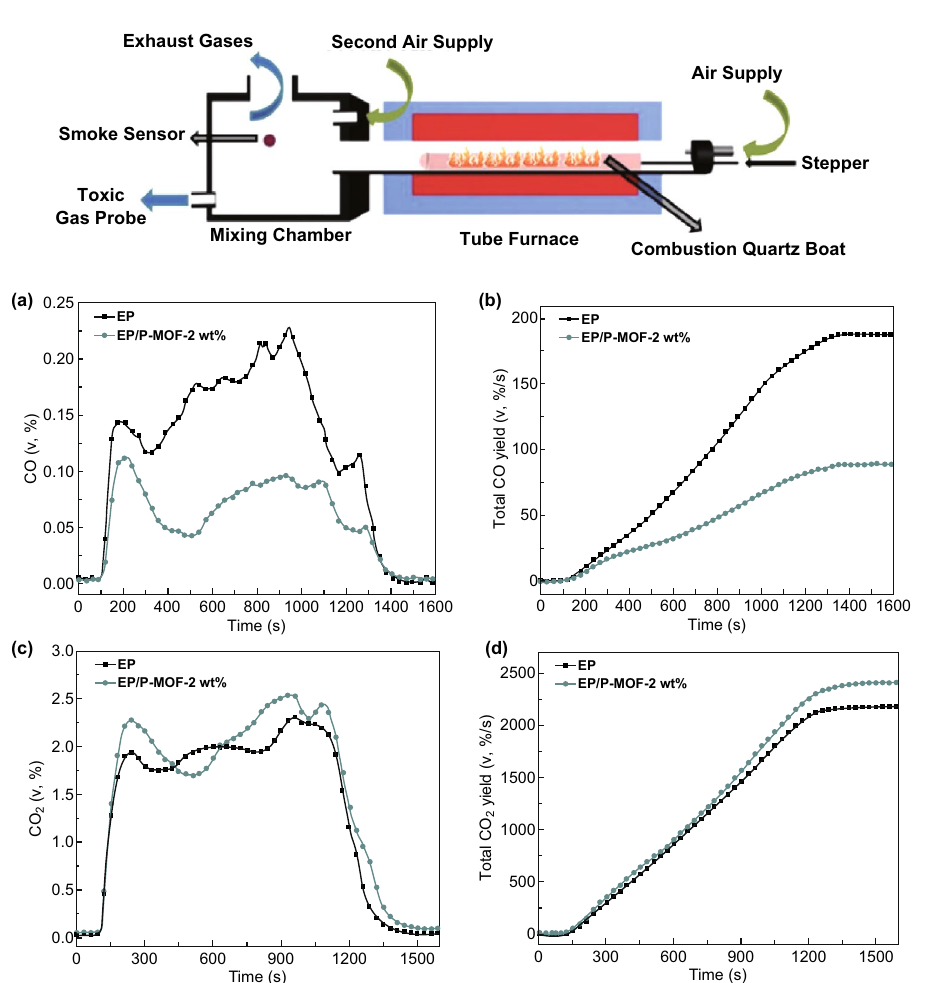
Fig. 11 ISO 19700 steady state tube furnace apparatus (Top) and corresponded data of CO ( a ) and CO 2 ( c ) and their total yield amount ( b , d ). Adapted from Ref. [25] with permission from